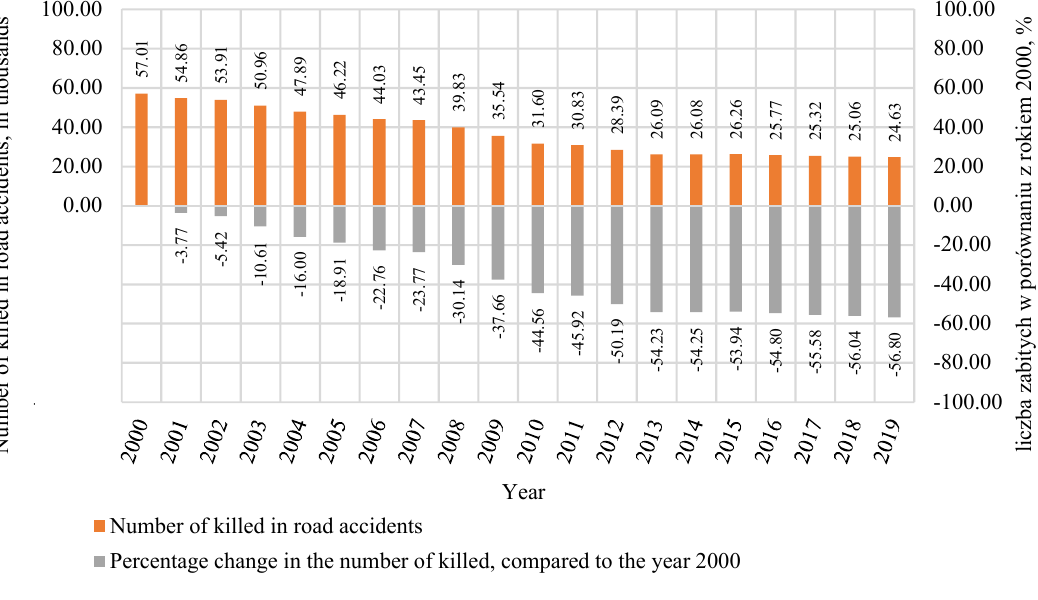
Figure 3. Number of fatalities in road accidents in Europe in 2000–2019 [11].